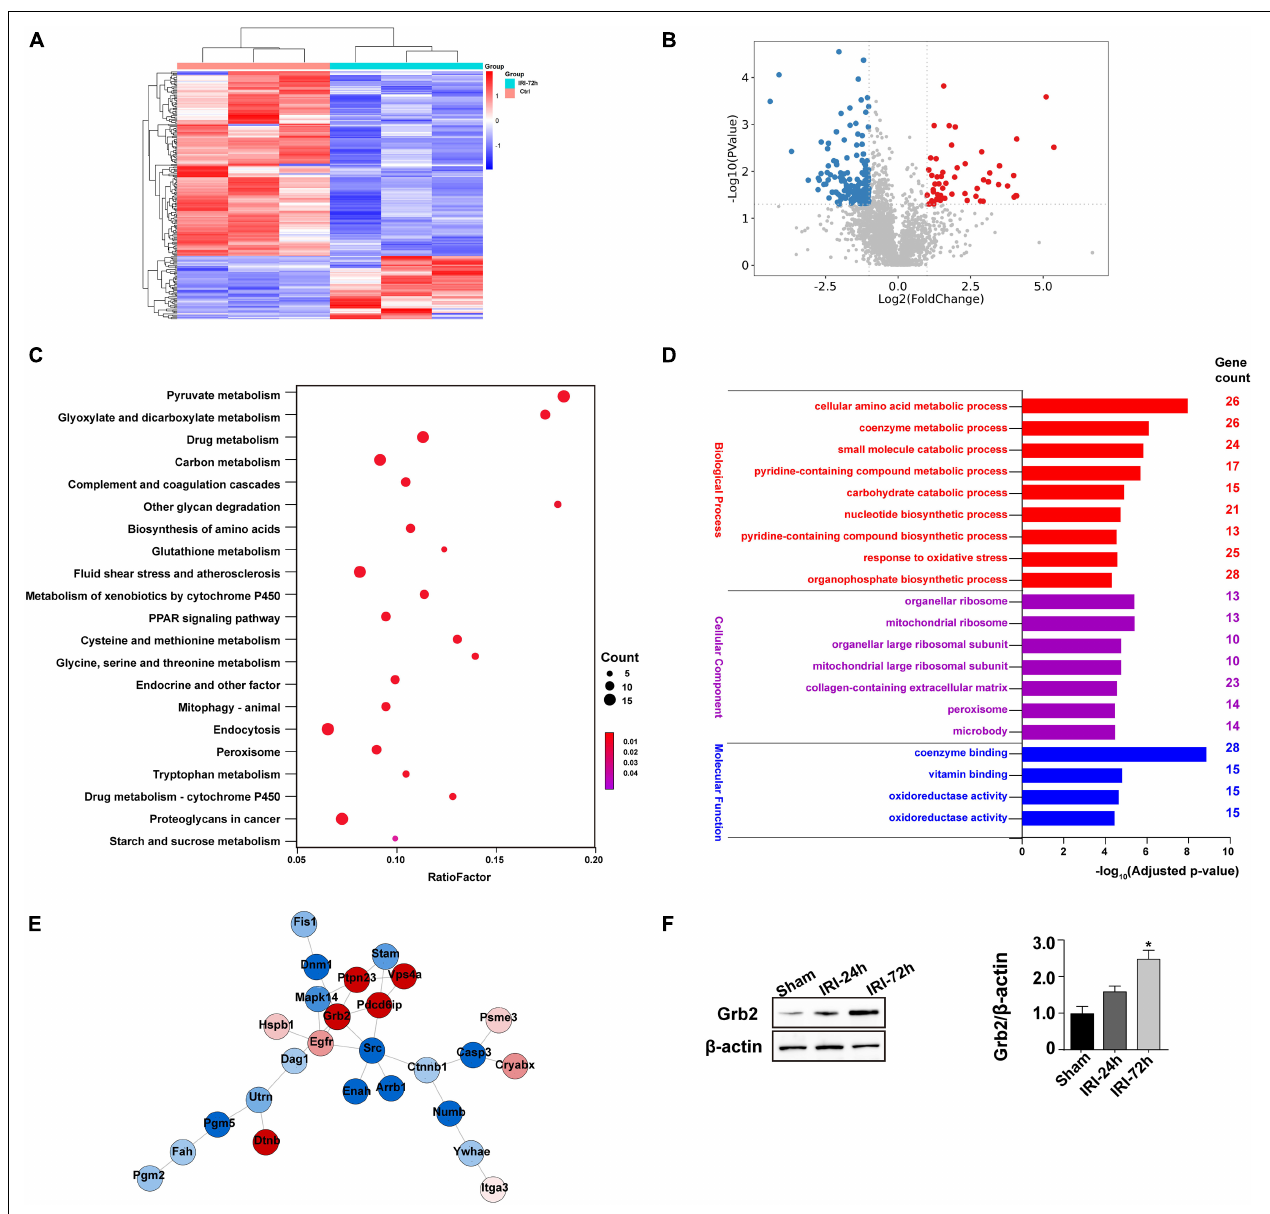
FIGURE 3 | Myocardial Grb2 expression is increased following acute kidney injury (AKI). (A) Heat map of the altered genes in the heart tissue after AKI. (B) VolcanoPlot of the altered genes in the heart tissue after AKI. (C) The Kyoto Encyclopedia of Genes and Genomes pathway analysis of altered genes in heart tissue after AKI. (D) Gene Ontology annotation was used to identify the molecular function, cellular components, and biological process of differentially expressed genes. (E) The protein–protein interaction network among the differentially expressed genes in heart tissue. (F) Verification experiments were performed through western blots using proteins isolated from heart tissue after AKI. * p < 0.05 vs. sham